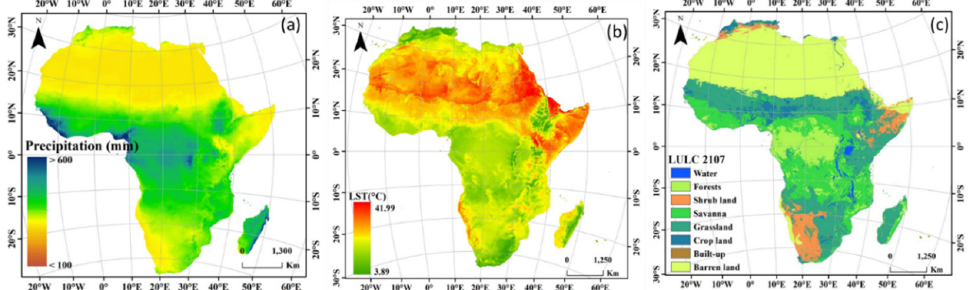
Figure 2. Annual mean Africa climate factors: ( a ) precipitation (mm), ( b ) land surface temperature (°C) from 2003 to 2017, and ( c ) land use/land cover classes from the MODIS satellite (MCD12C1, 2017).